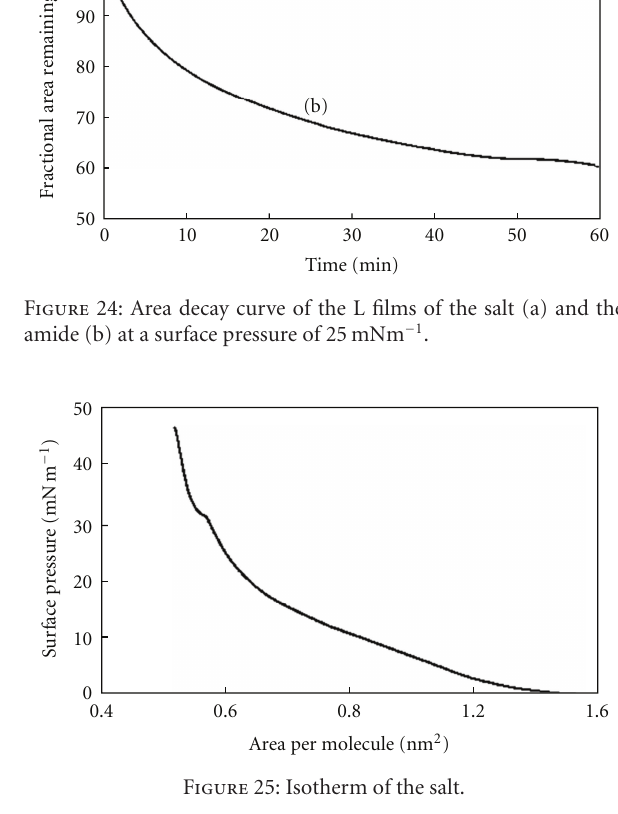
Figure 25: Isotherm of the salt.